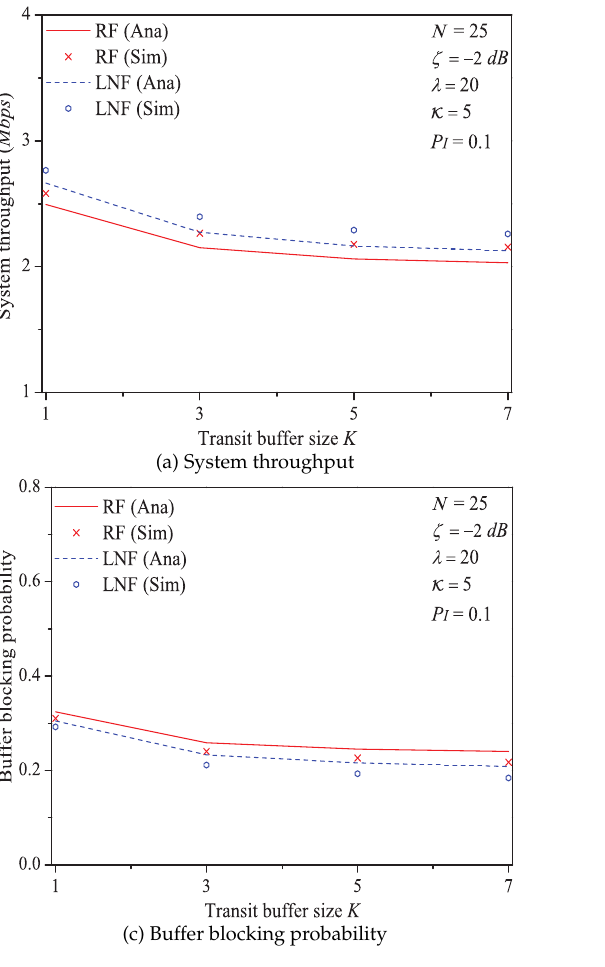
Figure 13. The MAC performance of 1901 protocol with different K